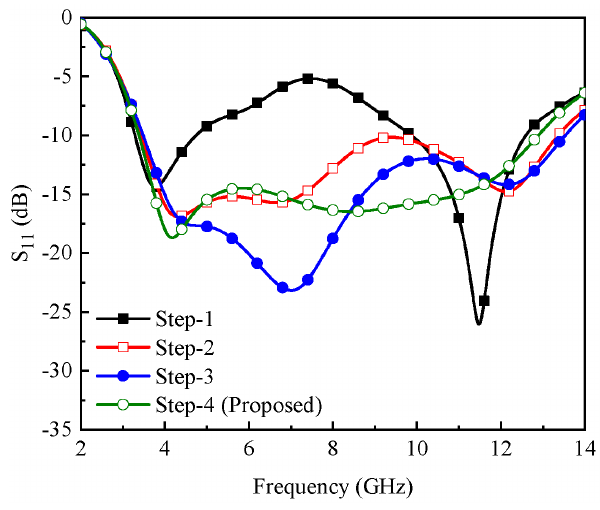
Figure 4. Reflection coefficient ( S 11 ) of different antenna designs shown in Figure 3.